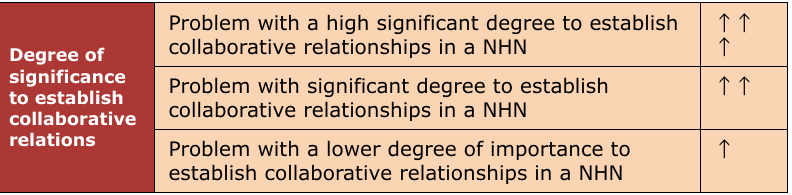
Table 3. Degree of significance for establishing collaborative